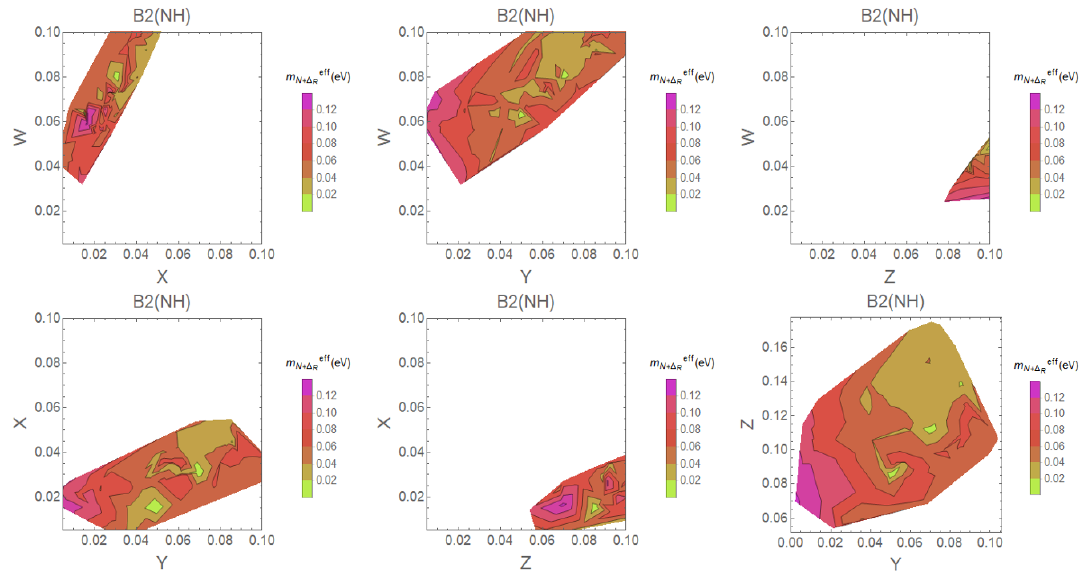
JHEP02(2019)129 Figure 14 . The various combinations of type II SS model parameters (in eV) with the new physics contribution to e(cid:11)ective mass as the contour, where 0.061 eV is the KamLAND-Zen upper limit in B2 class of two texture zero neutrino mass matrix for normal hierarchy. Figure 15 . The various combinations of type II SS model parameters (in eV) with the new physics contribution to e(cid:11)ective mass as the contour, where 0.061 eV is the KamLAND-Zen upper limit in B2 class of two texture zero neutrino mass matrix for inverted hierarchy. { 23